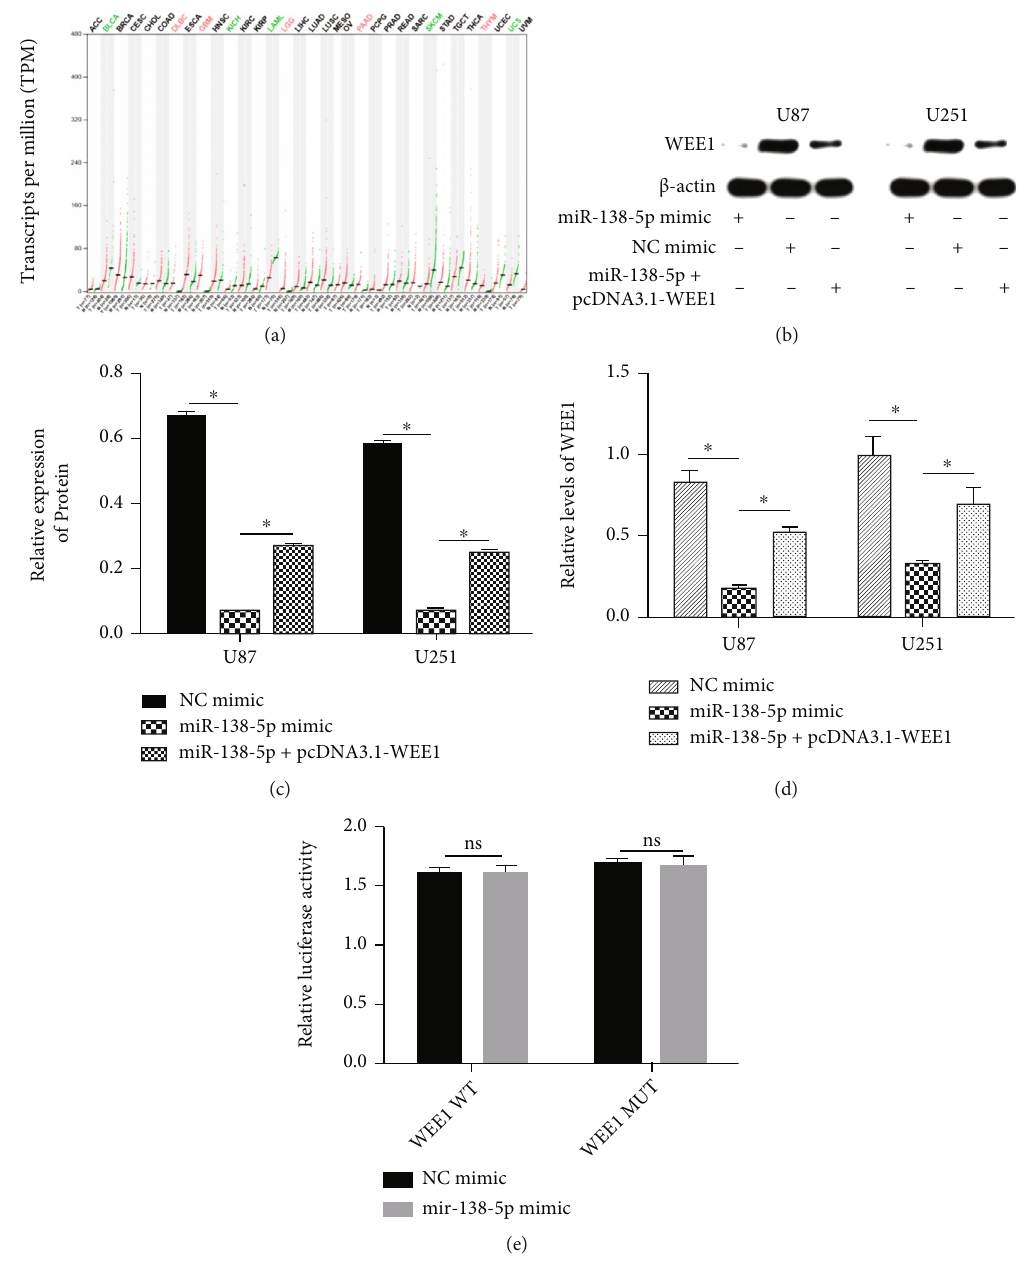
Figure 5: WEE1 is targeted by miR-138-5p at the 3 ′ -UTR. (a) Prediction of WEE1 expression in tumors by OncoLnc. (b, c) Western blotting showed that transfection with a miR-138-5p mimic reduced the levels of WEE1 protein in U87 and U251 cells. (d) qRT-PCR showed that the miR-138-5p mimic transfection reduced the levels of WEE1 mRNA in U87 and U251 cells. (e) Luciferase activity in U87 and U251 cells was measured using dual luciferase reporter genes. Each experiment was repeated at least three times. ∗ P < 0 : 05